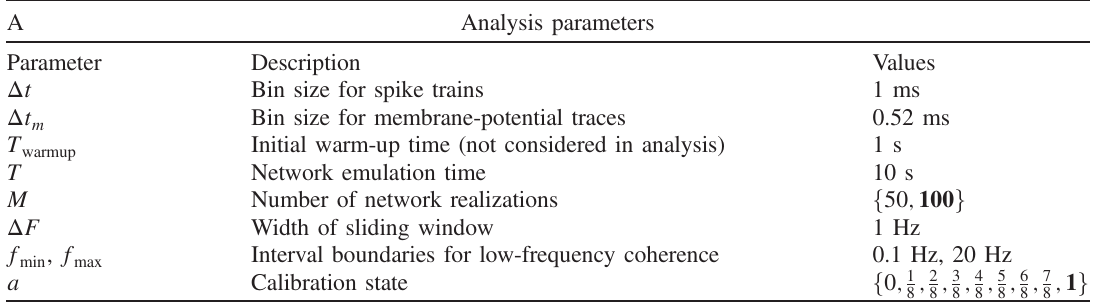
TABLE IV. Summary of analysis parameters (default values in